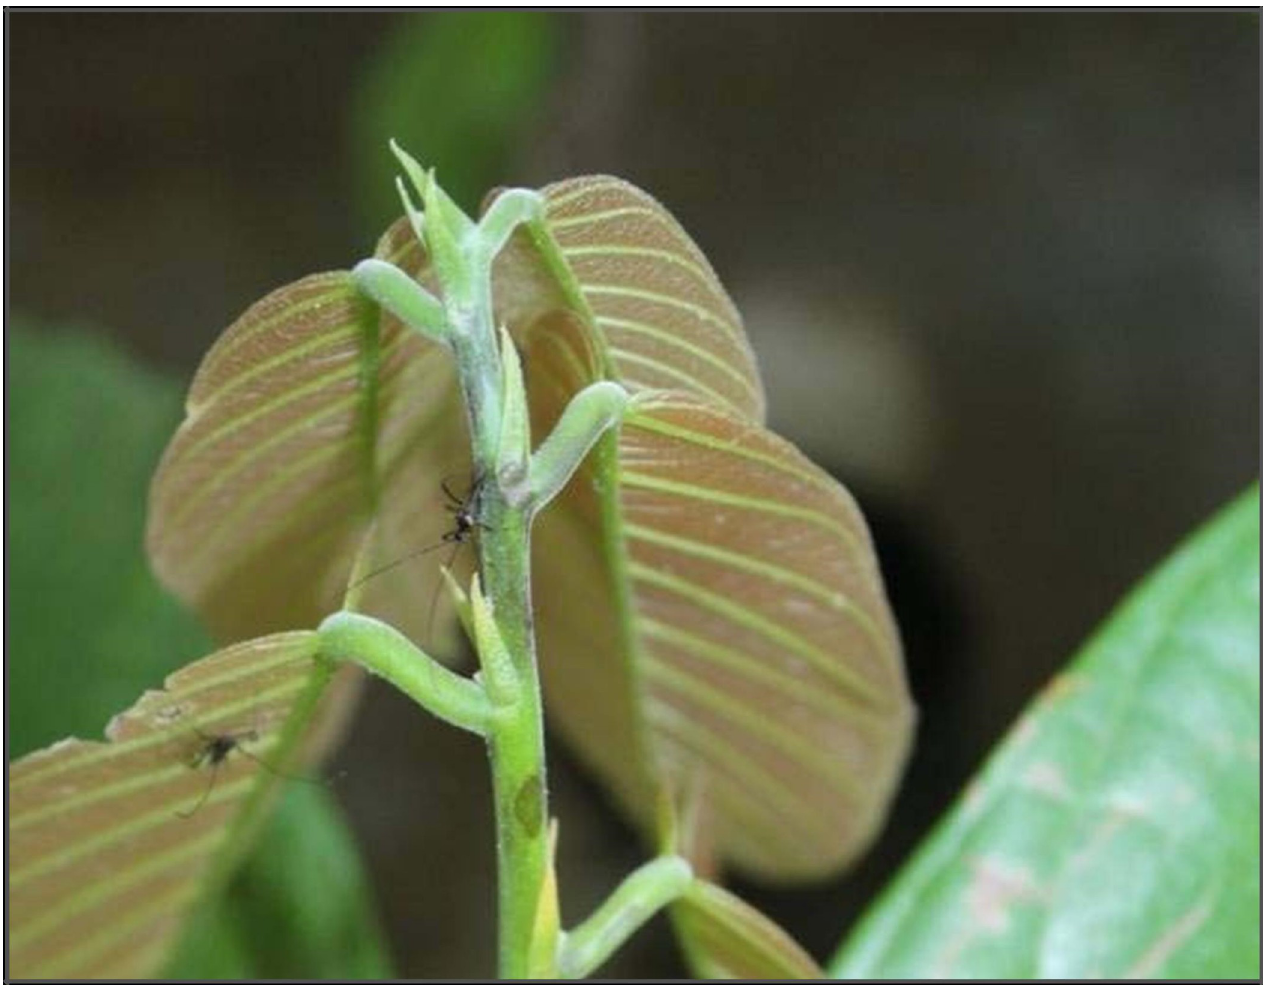
Fig 1. Screening on budded